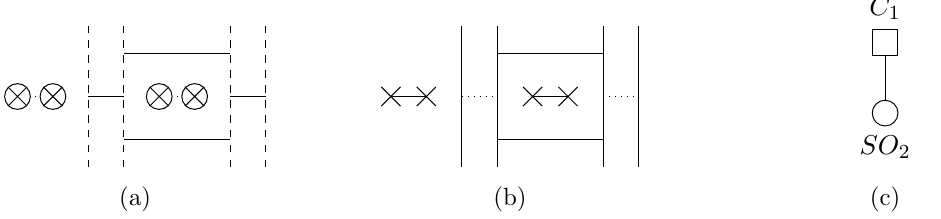
Figure 21. Model with M C = (cid:22) O I (cid:26) so (4). (a) is the Higgs branch con(cid:12)guration of the (2 ; 2) [ (cid:22) O II model with M H = (cid:22) O I . (b) is the Coulomb branch brane con(cid:12)guration that results after (2 ; 2) (2 ; 2) performing S-duality. (c) is the quiver read from (b) with a choice of SO 2 gauge node instead of O 2 . This choice is related to the fact that Lusztig’s Canonical Quotient (cid:22) A ( O